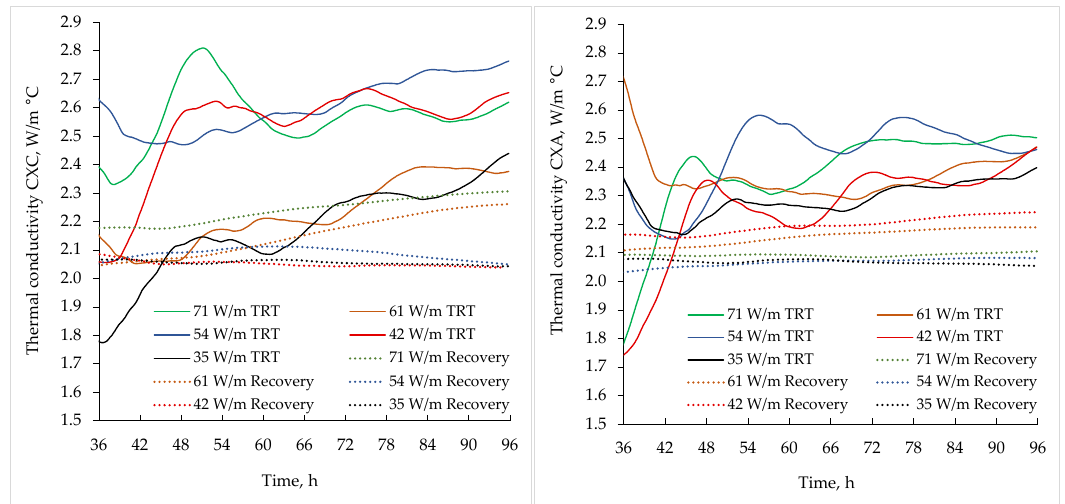
Figure 9. Results of the ground thermal conductivity values obtained for classic TRT and recovery period as a function of variable test time 36–96 h.